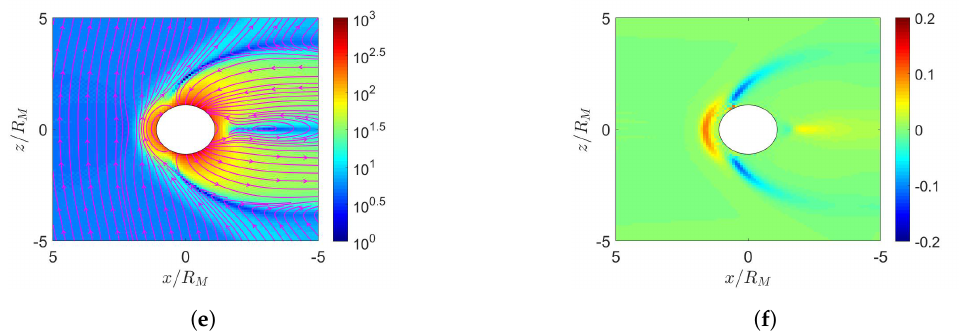
Figure 6. Distributions around Mercury of ( a ) n (cm − 3 ), ( b ) ¯ u xz (km/s), ( c ) magnetosonic Mach number, ( d ) P (nPa), ( e ) ¯ B xz (nT), ( f ) J y ( µ A/m 2 ); northward IMF, t = 1 min 58 s.